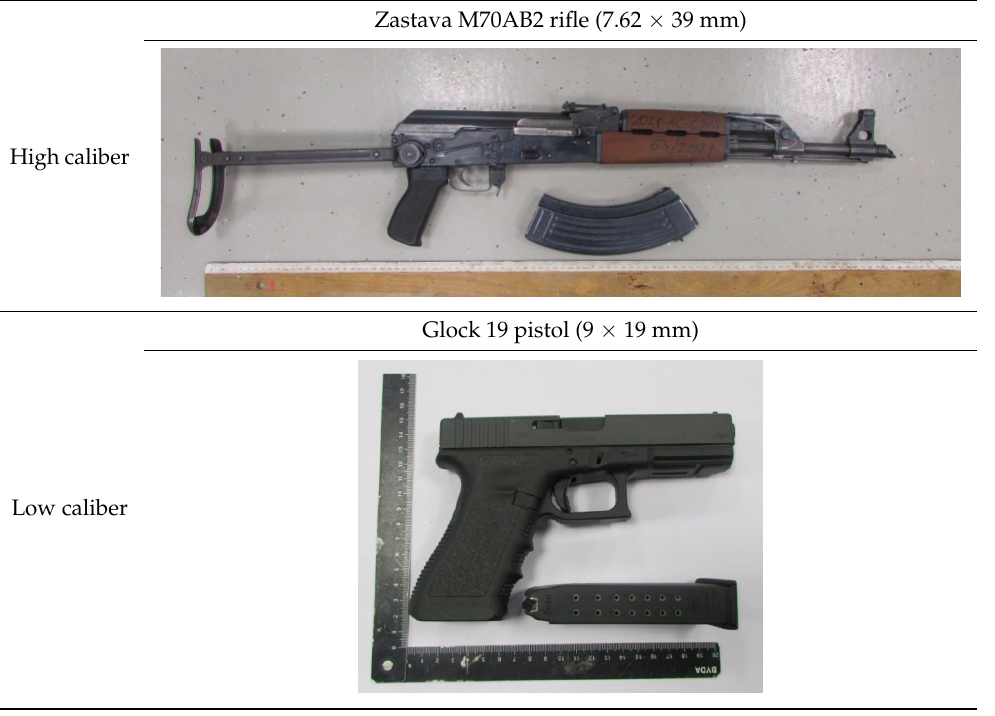
Table 3. Types of firearms used in the test.